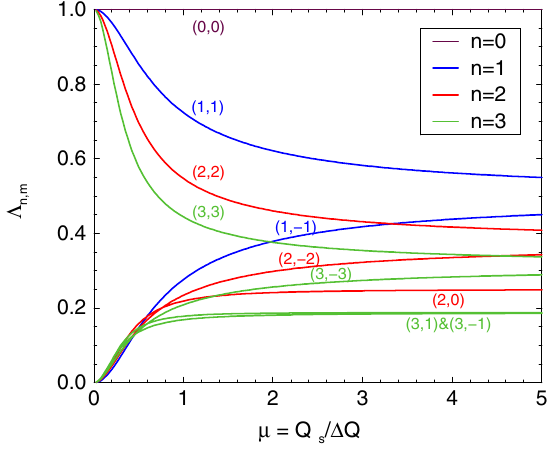
FIG. 3. Coefficients (cid:4) describing influence of synchrotron n;m oscillations and space charge tune shift on coherent oscillations of the boxcar bunch. The eigenmode characteristic numbers ð n; m Þ are marked near the